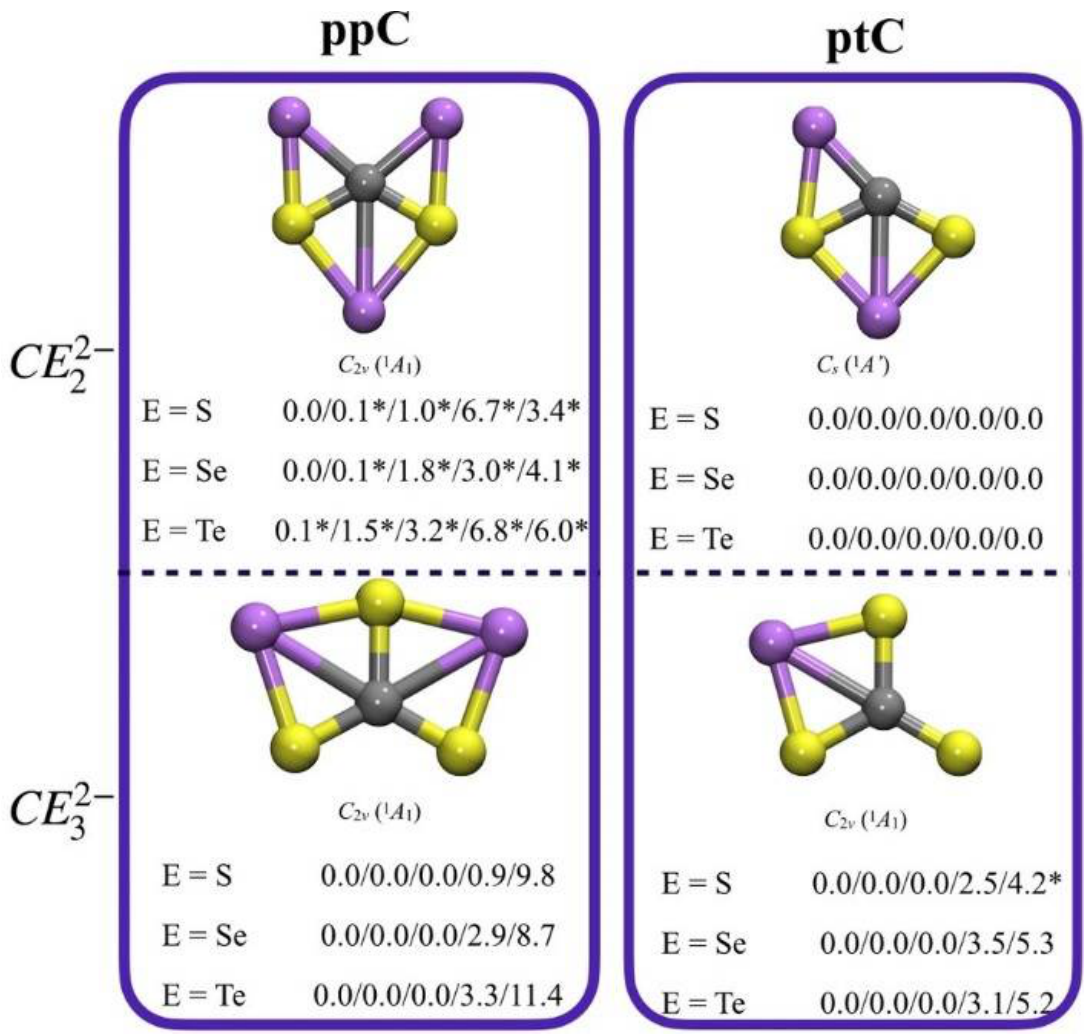
Figure 14. The ppC- and ptC-optimized structures resulting from the alkali metal decoration of CE 32− and CE 22− dianions (M 3 CE 2+ , M 2 CE 2 , M 2 CE 3, and MCE 3− ). Point group symmetries, electronic states, and relative energies (kcal mol −1 ) at the CCSD(T)/def2-TZVP//PBE0-D3/def2-TZVP level. The relative energies follow the Li/Na/K/Rb/Cs order. (Reprinted from ref. [95] with permission from Wiley. Copyright © 2022 Wiley-VCH GmbH).